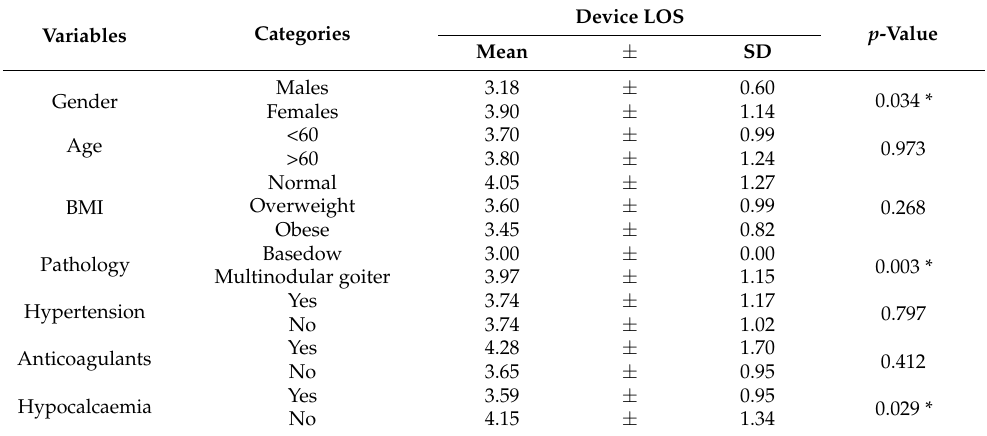
Table 3. Analysing variables influencing LOS for Device group. Statistically significant results (significance level = 0.05) = *. Abbreviation: BMI: Body Mass Index.